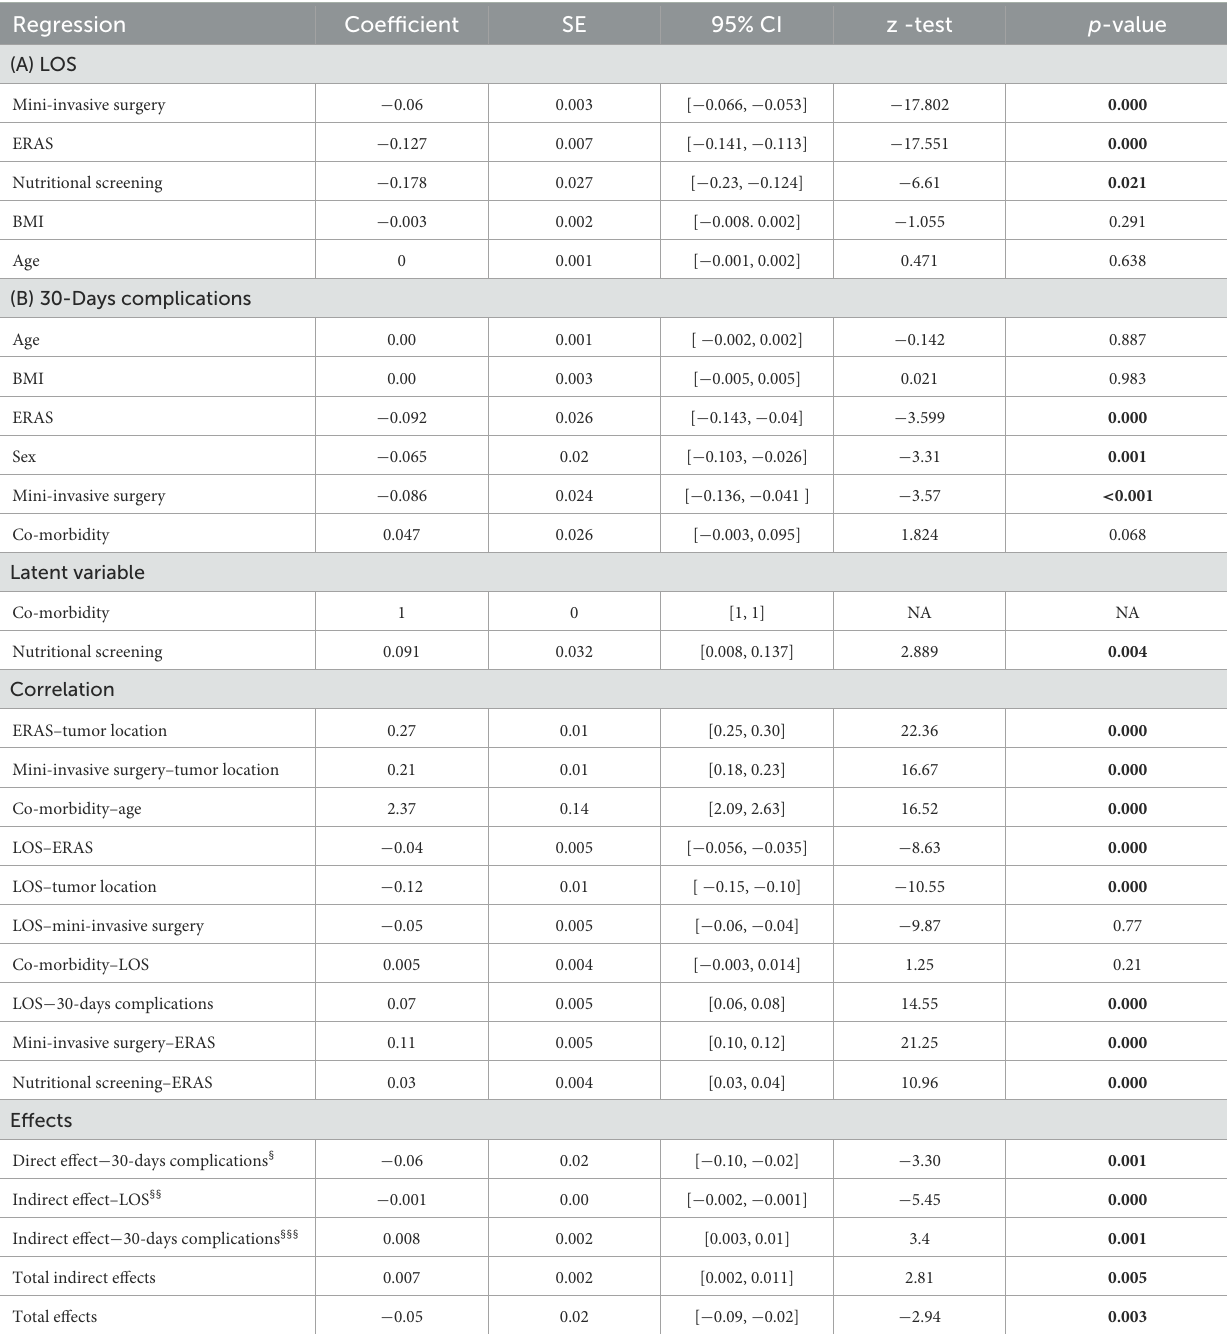
TABLE 4 Structural equation modeling analysis ∗